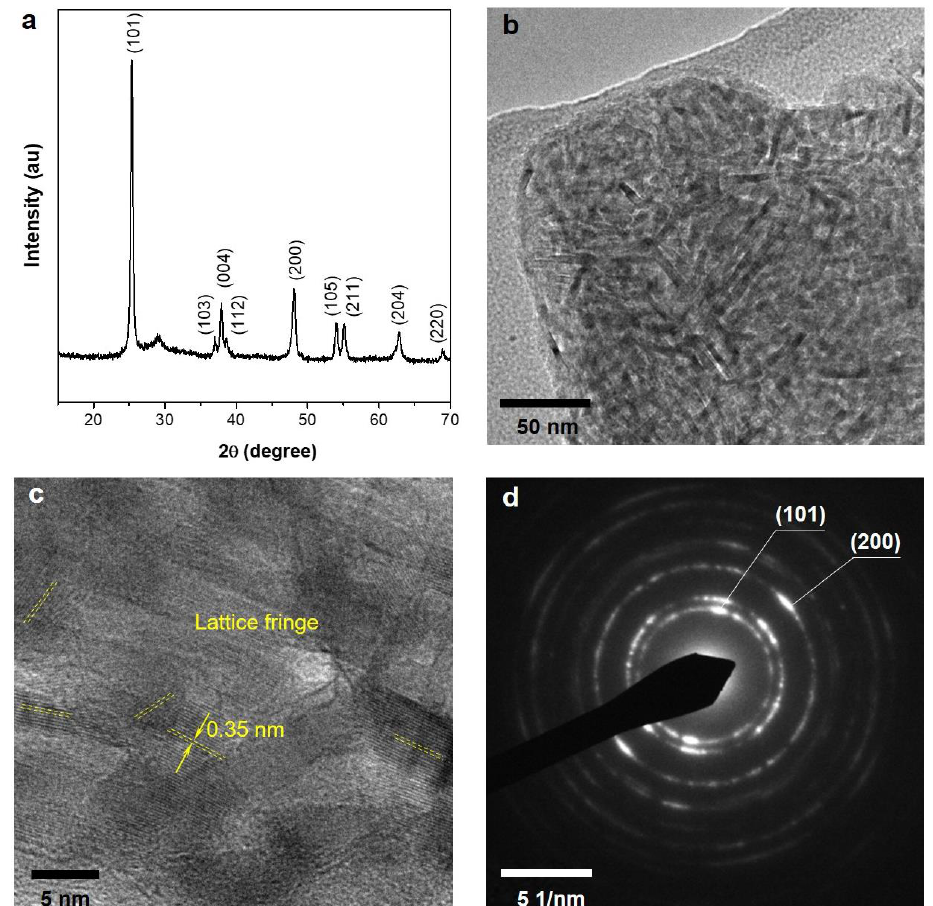
Figure 1. ( a ) XRD spectra of the obtained porous TiO 2 , ( b ) transmission electron microscopy (TEM) image, ( c ) High-Resolution Transmission Electron Microscope (HRTEM) image and ( d ) selected area electron diffraction (SAED) pattern of the porous TiO 2 .